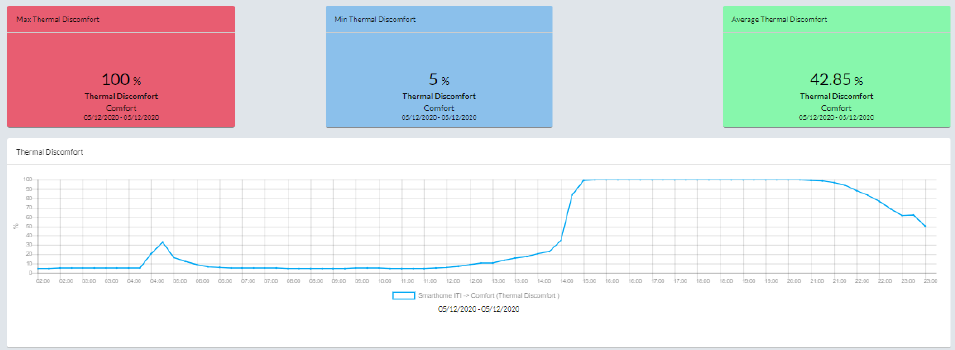
Figure 10. Discomfort tool monitoring and real time visualization to the UI.